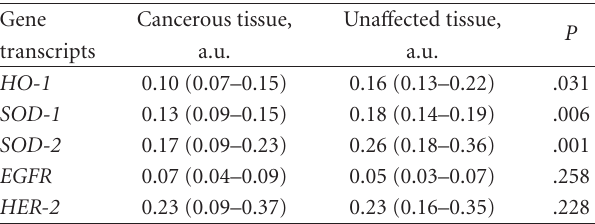
Table 2: Distribution of gene transcript levels (medians and interquartile (25th–75th) ranges of values in arbitrary units, a.u) in cancerous and una ff ected tissues. Results of paired sample analysis (Wilcoxon’s test) are shown ( P )